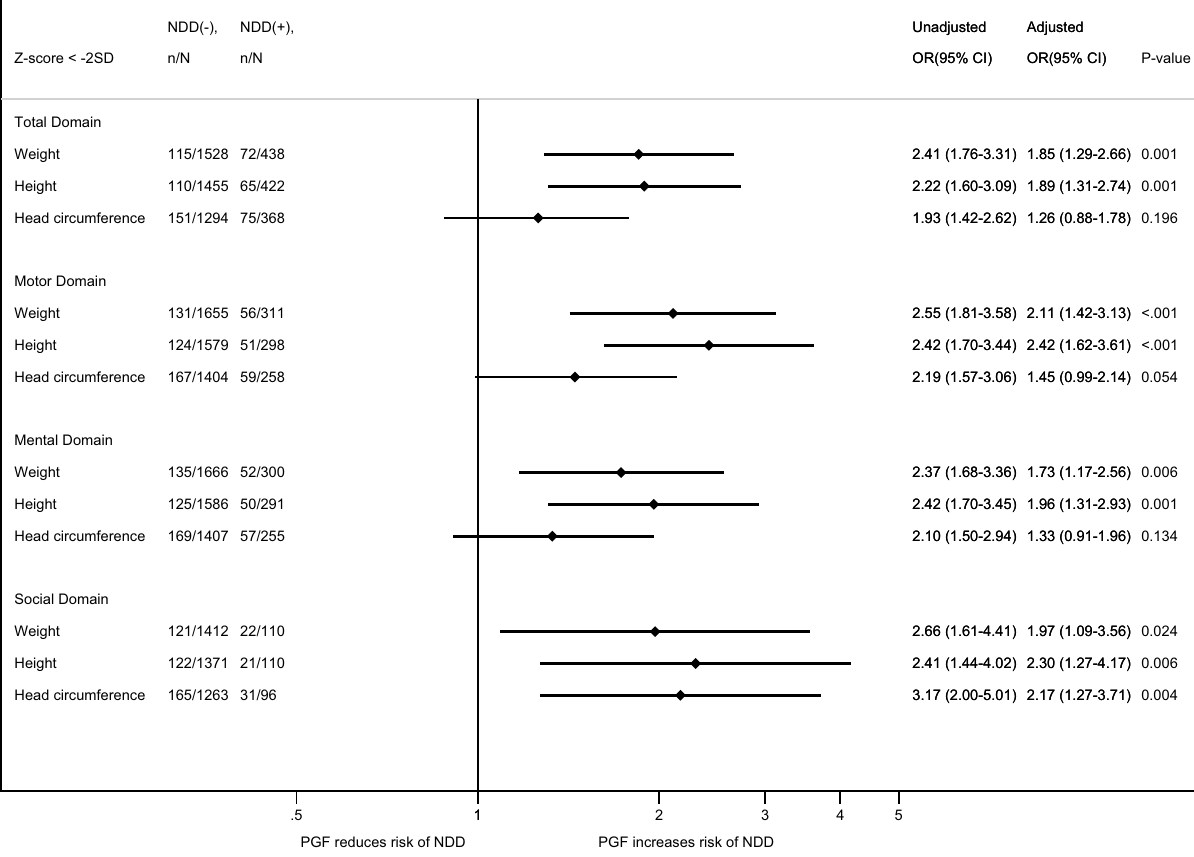
Figure 2. Relationship between postnatal growth failure and neurodevelopmental delay at 18–24 months’ corrected age. Abbreviations: NDD, neurodevelopmental delay; OR, odd ratio; CI, confidence intervals; PGF, postnatal growth failure (Z-score < −